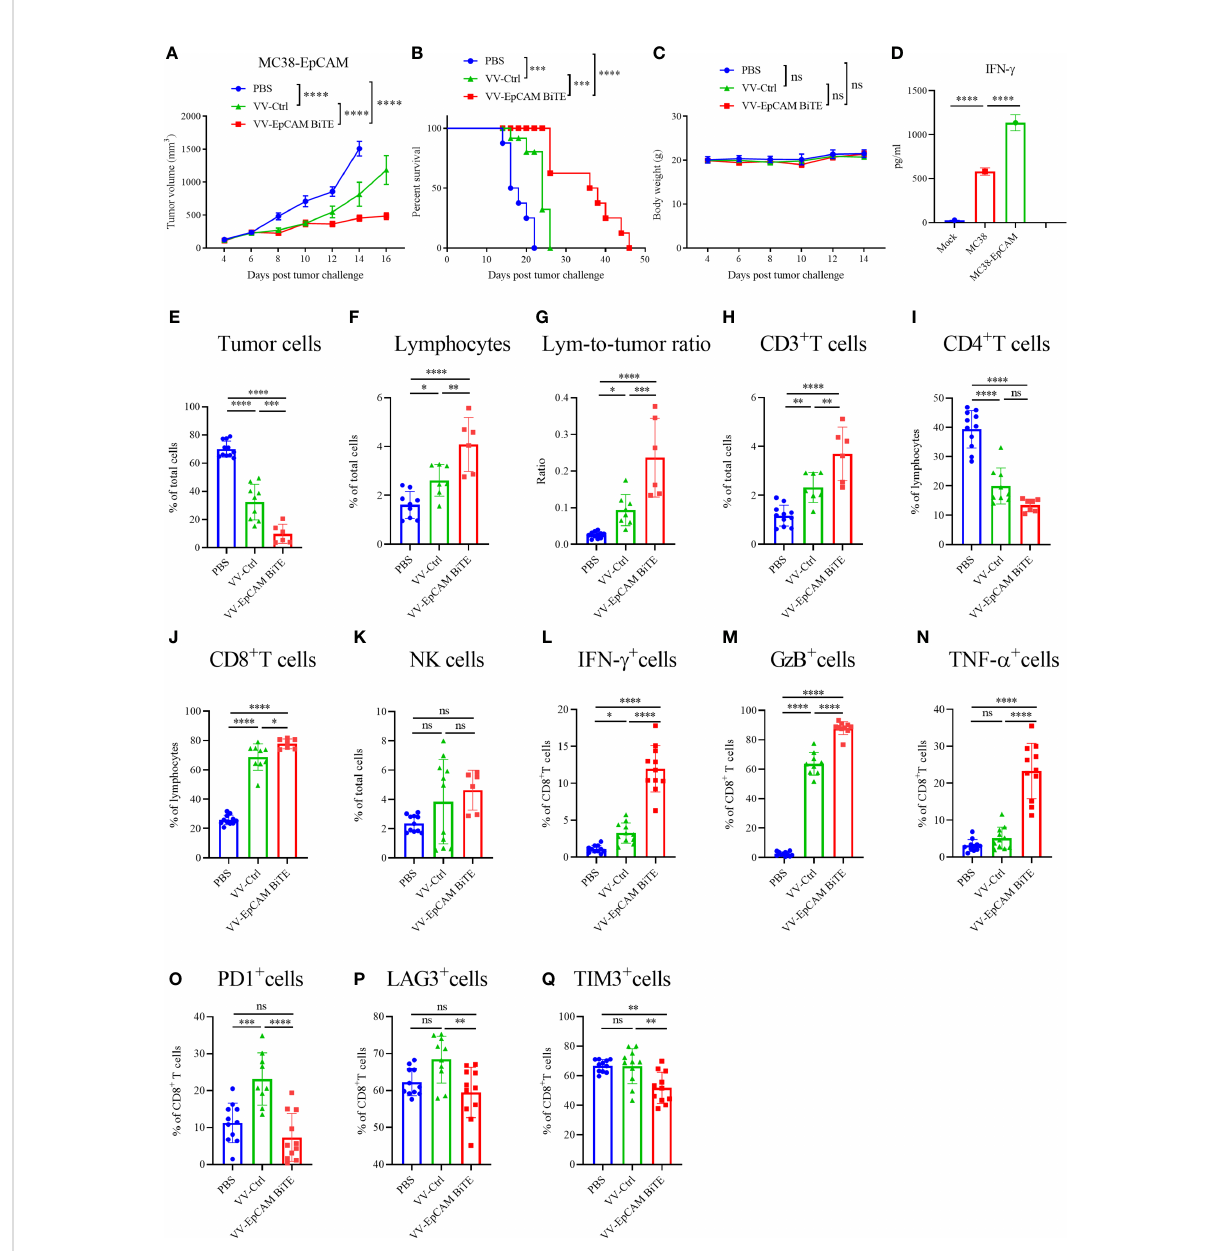
FIGURE 6 Antitumor effect of VV-EpCAM BiTE in the MC38-EpCAM model. (A) The volumes of MC38-EpCAM tumors were monitored by caliper measurement. Data are presented as means±SEM. (B) Kaplan-Meier survival curves of MC38-EpCAM-bearing mice. (C) Body weight of MC38-EpCAM-bearing mice. (D) Expression levels of IFN- g . After 1 x 10 7 pfu VV-EpCAM BiTE treatment of tumor-bearing mice for 48h, mice were sacri fi ced and splenocytes were prepared. Splenocytes were co-incubated with MC38 or MC38-EpCAM cells for 48h. The production of IFN- g was measured by ELISA. (E-Q) Flow cytometry analysis of the proportion of tumor cells (E) , lymphocytes (F) , lymphocyte-to-tumor ratio (G) , CD3 + T cells (H) , CD4 + T cells (I) , CD8 + T cells (J) , NK cells (K) , IFN- g + CD8 + T cells (L) , GzB + CD8 + T cells (M) , TNF- a + CD8 + T cells (N) , PD1 + CD8 + T cells (O) , LAG3 + CD8 + T cells (P) and TIM3 + CD8 + T cells (N) . Data are presented as the means± SD (n=6-11). ns, no signi fi cant differences; *p < 0.05; **p < 0.01; ***p < 0.001; ****p <